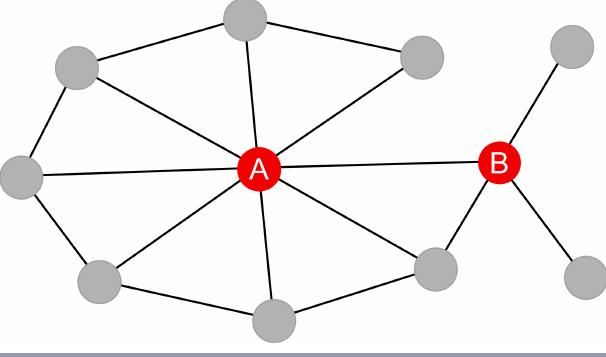
Fig. 1 . Illustrations of network positions of periphery connector (A) and central coordinator (B)